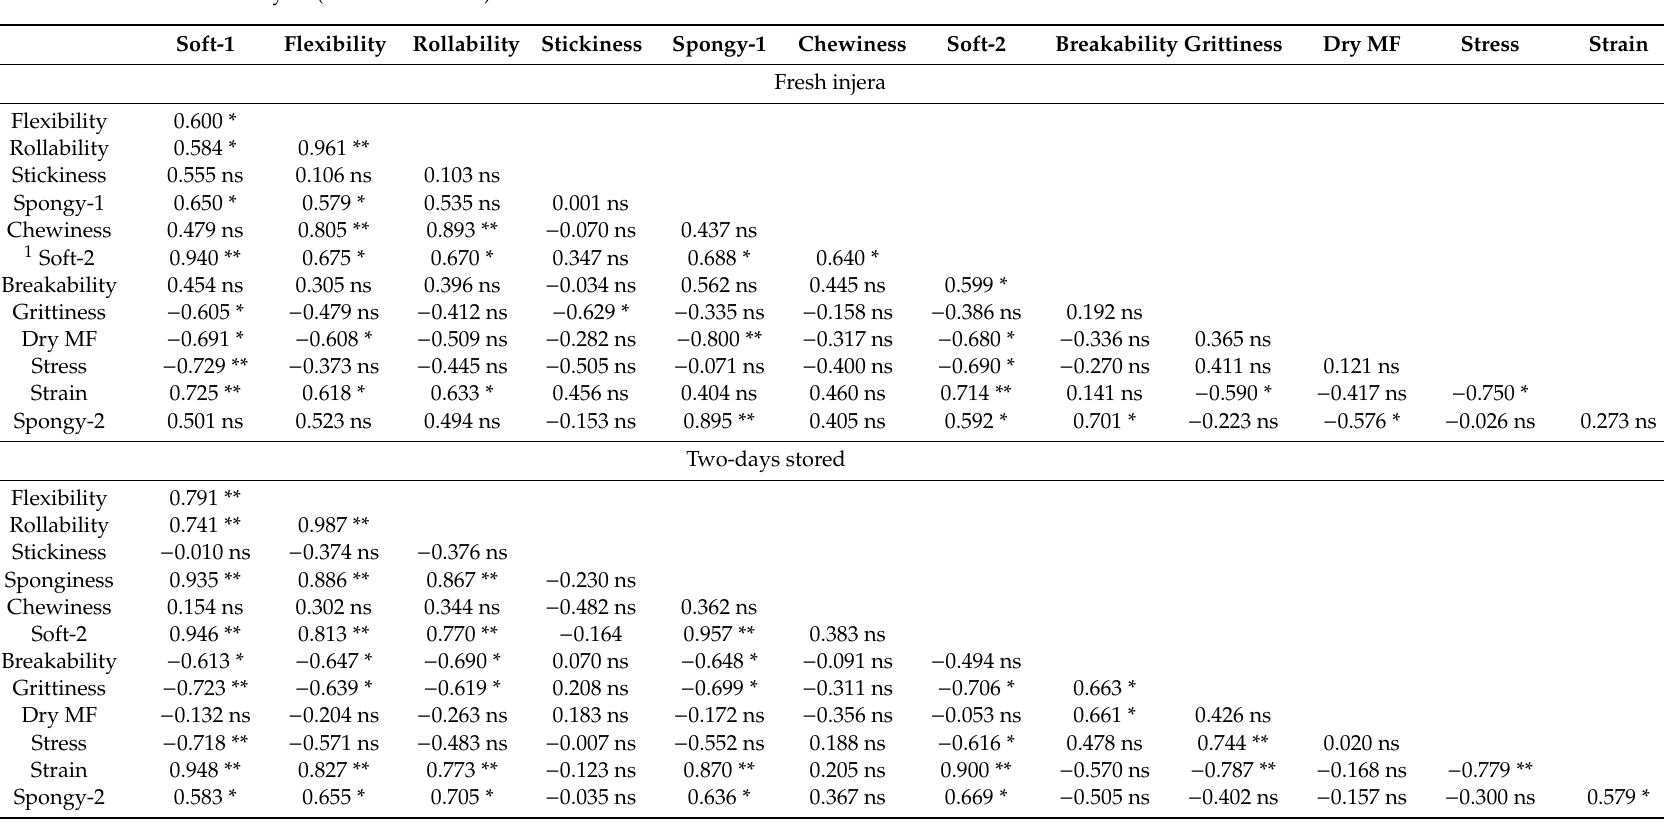
Table 5. Correlation matrix of textural properties of the freshly prepared and 2- and 4-day stored sorghum injera measured by the descriptive sensory panel and by instrumental texture analysis (stress and